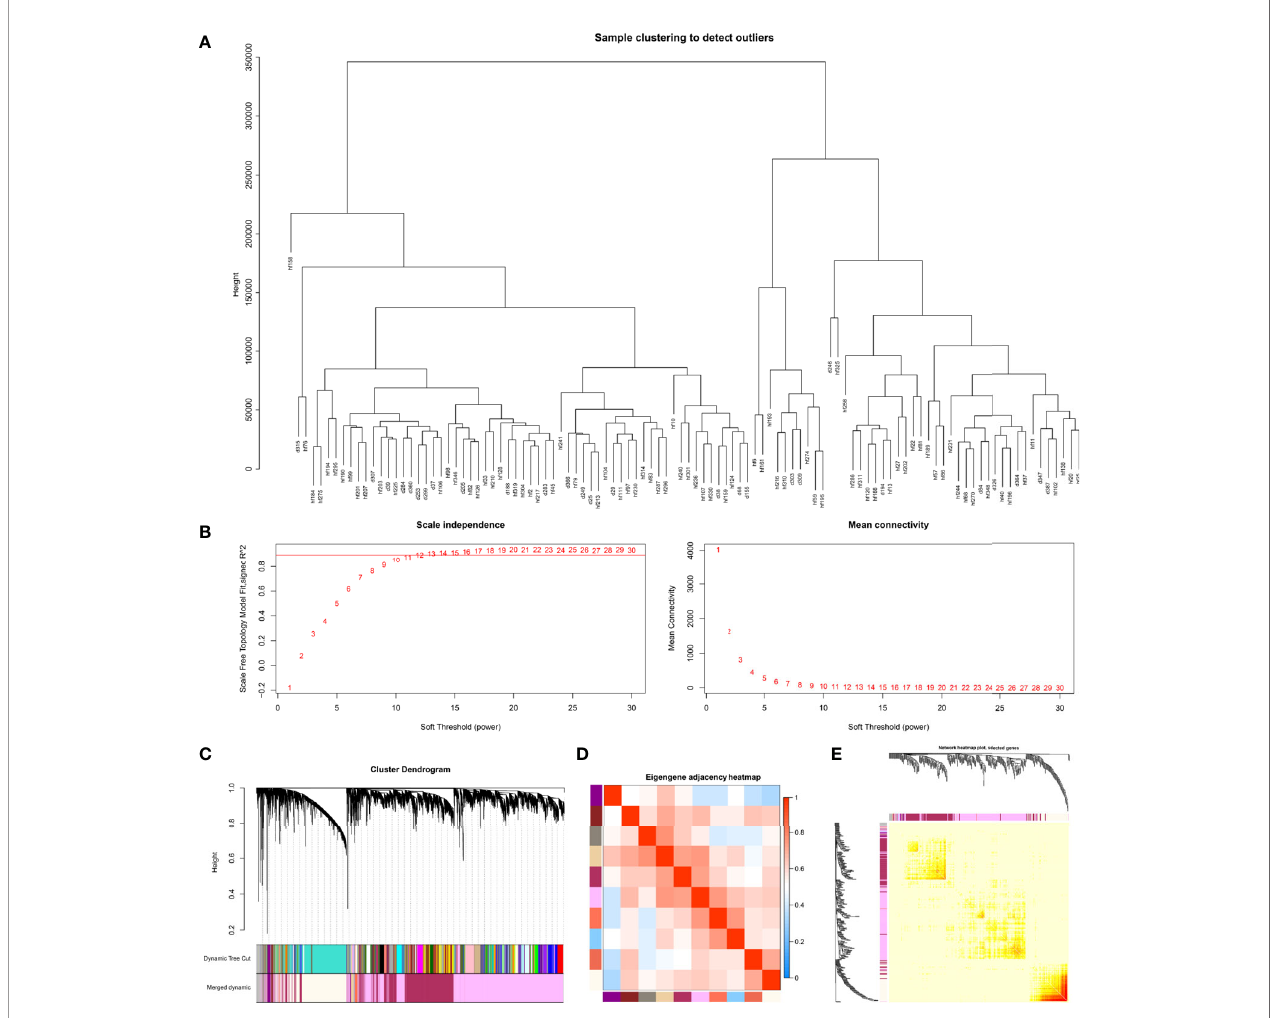
FIGURE 1 | (A) Sample clustering to detect outliers. All samples were in the clusters and there was no outlier. (B) Analysis of network topology for different soft ‐ thresholding powers. The soft-thresholding power of 10 was selected for scale-free topology construction. (C) Clustering dendrogram of genes with dissimilarity based on the topological overlap, together with assigned module colors. (D) Eigengene adjacency heatmap. The color of column and row square represents the adjacency of corresponded modules. In the heatmap, red represents high adjacency (positive correlation), while blue color represents low adjacency (negative correlation). Squares of red color along the diagonal are the meta ‐ module. (E) Network heatmap plot of 1000 randomly-selected genes. Light color represents low overlap and darker color represents higher overlap. The gene dendrogram and module assignment are also shown along the left side and the